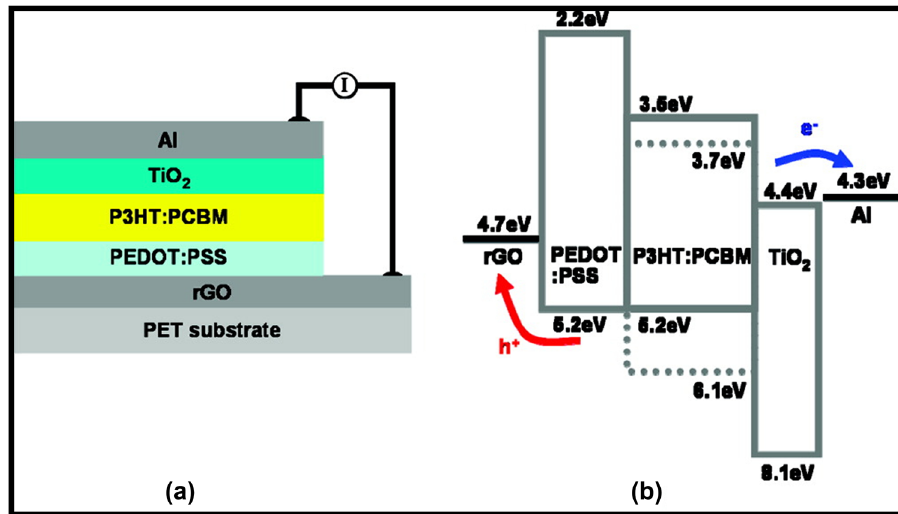
Figure 17: Schematic representation of ( a ) layer structure and ( b ) energy level for the OPV device, which is rGO/PEDOT:PSS/P3HT:PCBM/ TiO 2 /Al, with rGO as the transparent electrode [ 141 ] . PSS: poly ( styrene sulfonate ) .